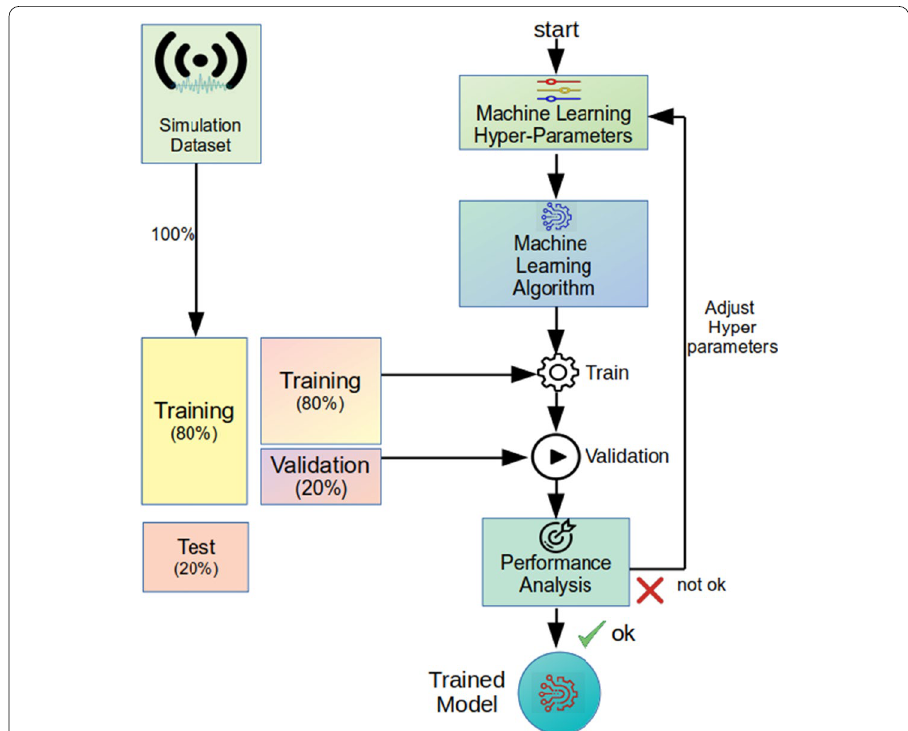
Fig. 7 Training process using only simulation